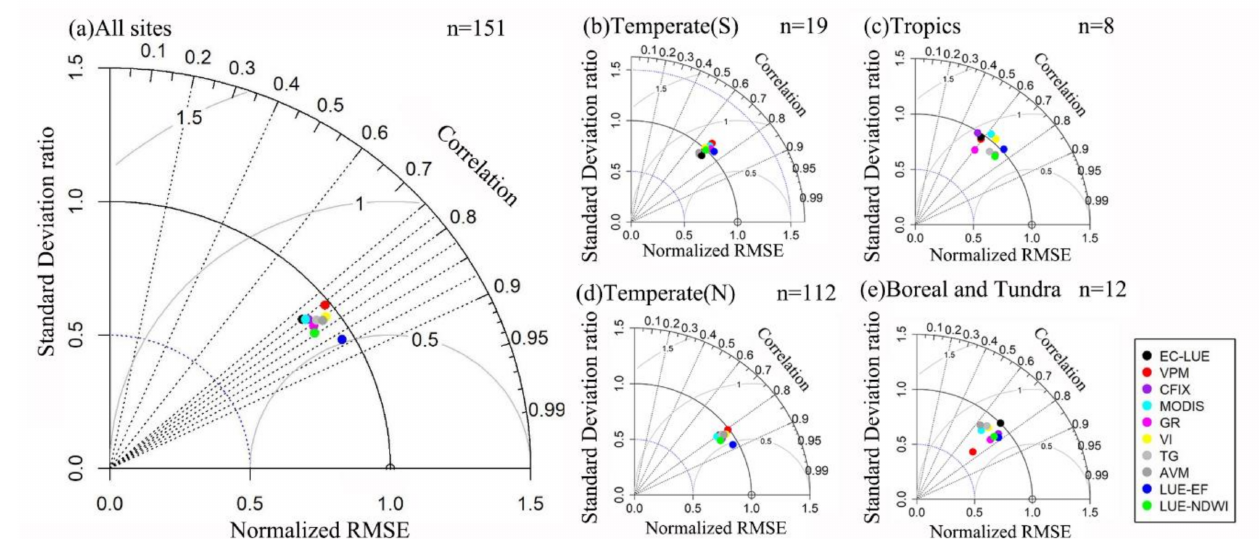
Figure 1. The Taylor diagram showing ( a ) the performance of all models, data from eddy covariance (EC) towers were used.; ( b – e ) the performance of all models in different latitudinal geographical zones (tropics: − 23.5 ◦ –23.5 ◦ , temperate: − 23.5 ◦ − ( − 66.5 ◦ ) and (23.5 ◦ − 66.5 ◦ ), boreal and tundra: 66.5 ◦ –90 ◦ ), where N and S represent the Northern and Southern hemi- spheres, respectively. The upper right corner of subplot "n" is number of